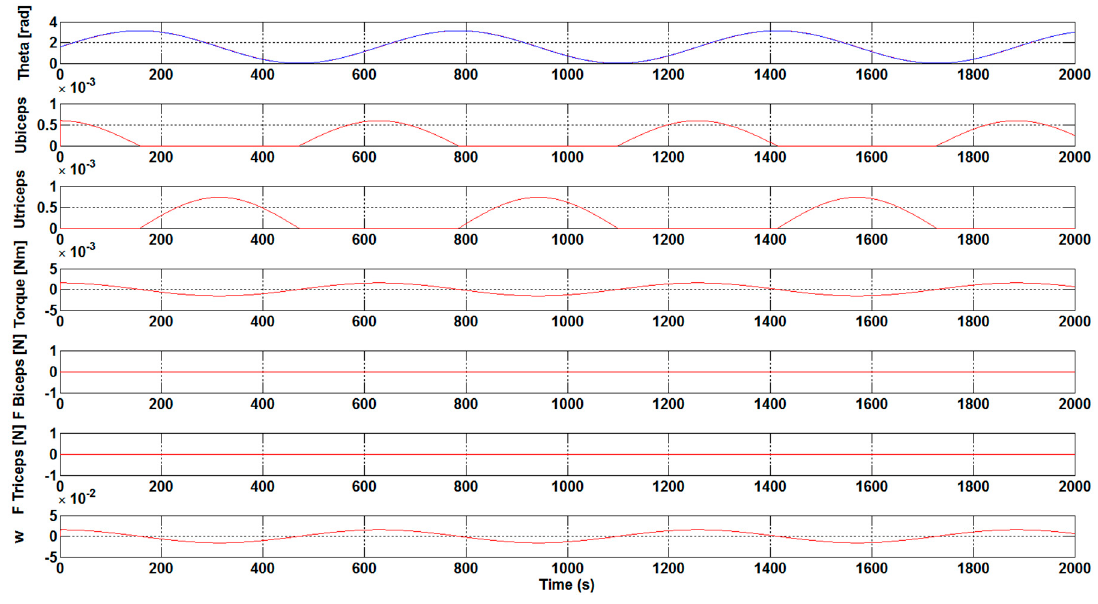
Figure 5. Results with the optimization algorithm and with a K control gain value of 0.1.